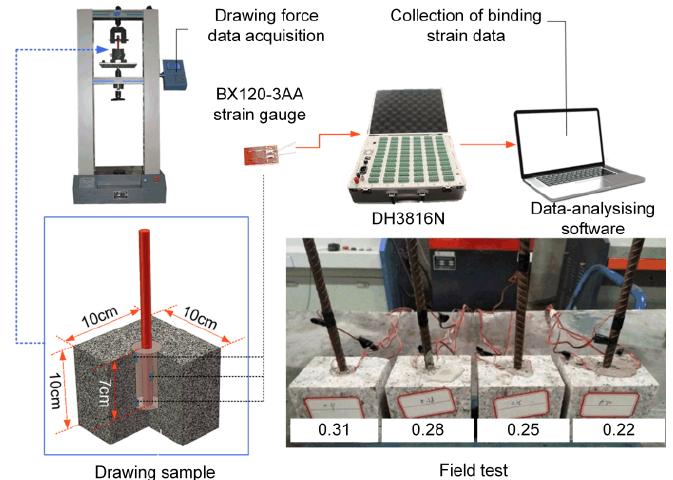
Figure 5. Pull-out test